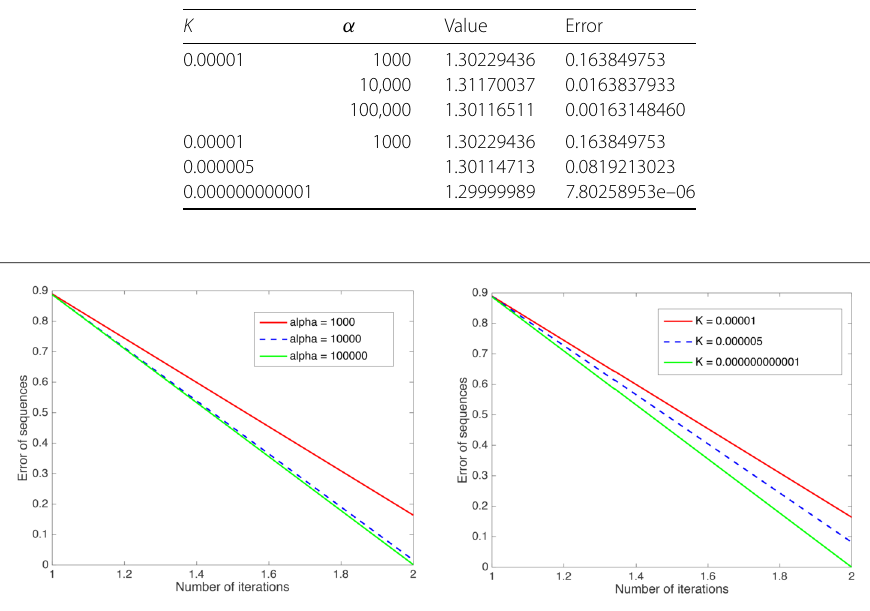
Figure 3 The error step of the sequence { s n } with different values of α with K = 0.00001 and different values of K with α =